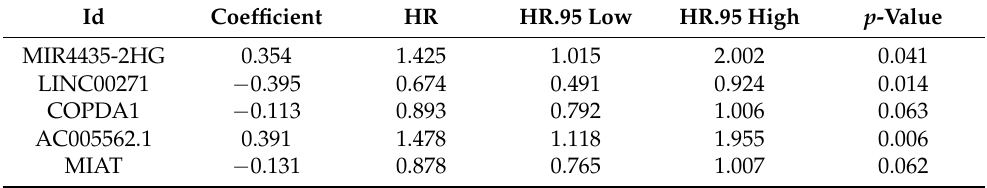
Table 1. Results of multivariate cox regression analysis of 5 m6A-related eRNAs and their coefficients.